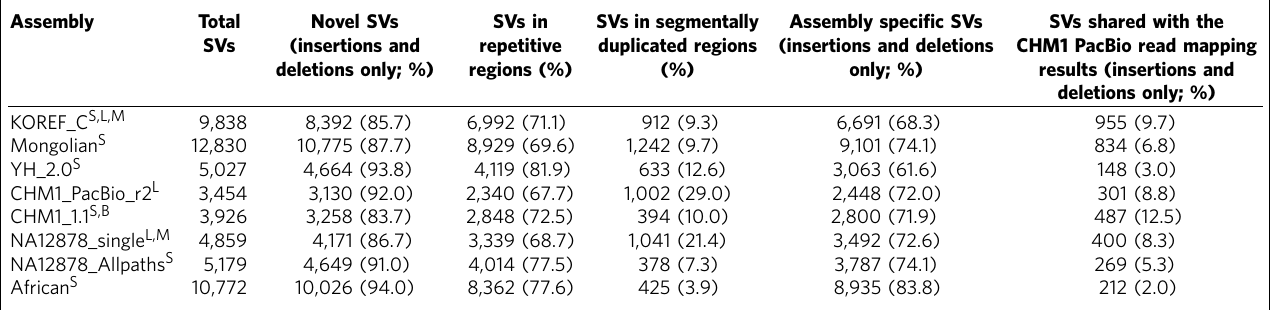
Table 3 | Summary of SVs in eight human assemblies compared with